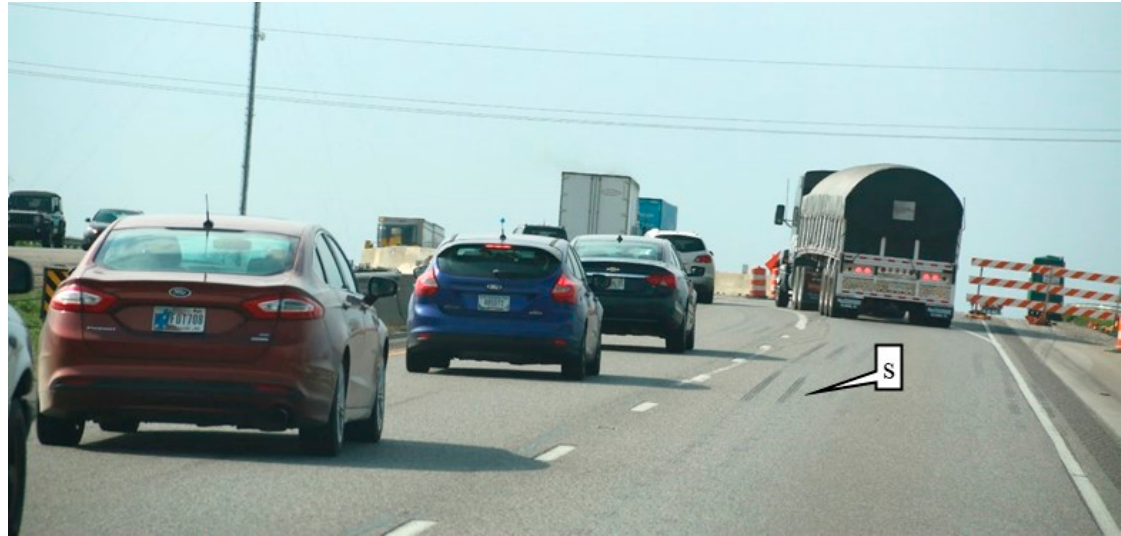
Figure 14. I-65 NB around MM 154.4 at Manson and Colfax.